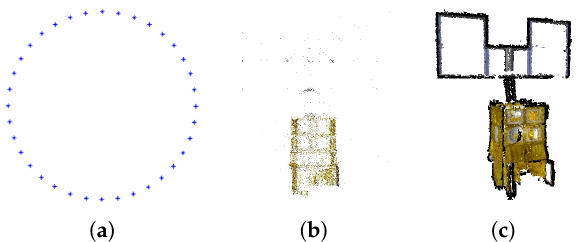
Figure 3. Correct reconstruction with modified image adding strategy. ( a ) Poses; ( b ) point cloud (sparse); ( c ) point cloud